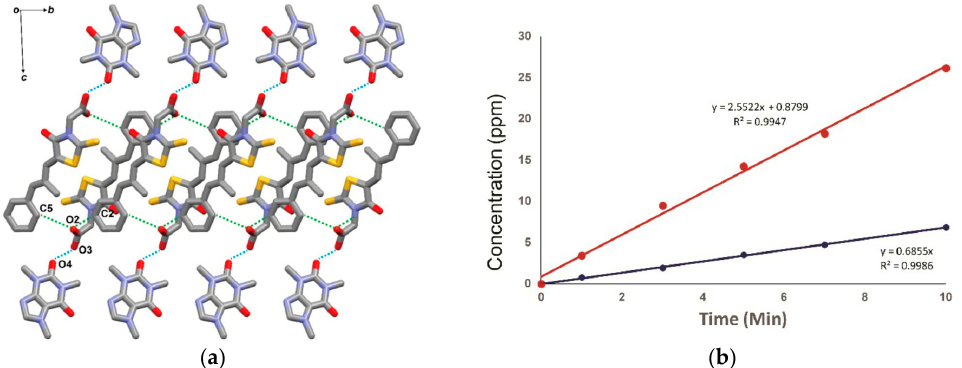
Figure 16. ( a ) Layered structure of 1:1 caffeine-epalrestat cocrystal connected through O–H···O hydrogen bond. Hydrogen atoms were removed for clarity. ( b ) Intrinsic dissolution rate of caffeine-epalrestat cocrystal (red) compared with pure epalrestat drug (blue). Adapted with permission from CrystEngComm, 2017, 19, 2614–2622. Copyright 2017, The Royal Society of Chemistry.